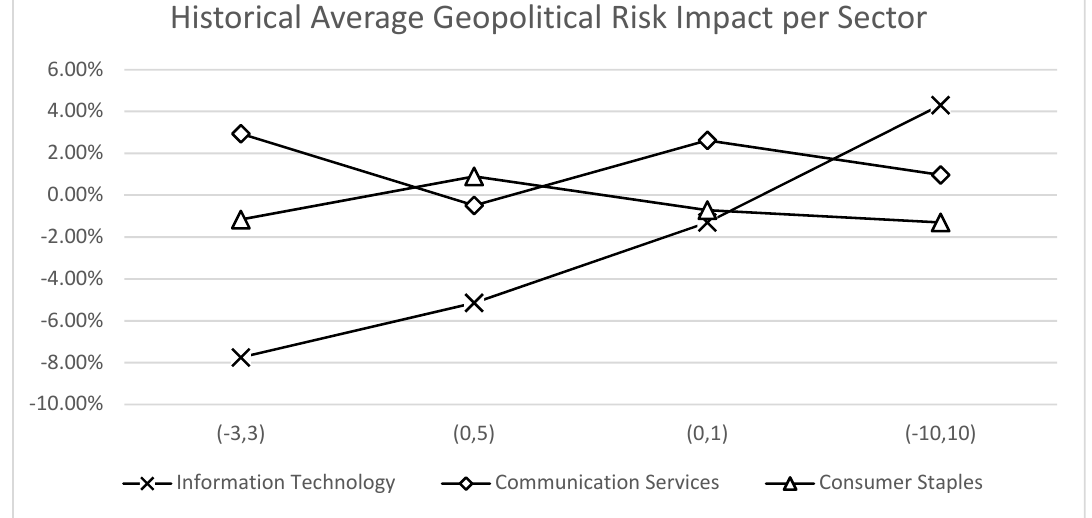
Figure A4. Summary of events with statistically significant CAARs for the Information Technology, Communication Ser- vices, and Consumer Staples sectors. References (Agmon 1973) Agmon, Tamir. 1973. Country Risk: The Significance of the Country Factor for Share-Price Movements in the United Kingdom, Germany, and Japan. The Journal of Business 46: 24–32. Available online: http://www.jstor.com/stable/2351277 (accessed on 20 March 2020). (Amiti et al. 2019) Amiti, Mary, Stephen J. Redding, and David E. Weinstein. 2019. The Impact of the 2018 Tariffs on Prices and Welfare. Journal of Economic Perspectives 33: 187–210. doi: 10.1257/jep.33.4.187. (Antonakakis et al. 2017) Antonakakis, Nikolaos, Rangan Gupta, Christos Kollias, and Stephanos Papadamou. 2017. Geopolitical risks and the oil-stock nexus over 1899–2016. Finance Research Letters 23: 165–73. https://doi.org/10.1016/j.frl.2017.07.017. (Atems et al. 2020) Atems, Bebonchu, Michael Maresca, Baomei Ma, and Emily McGraw. 2020. The impact of El Nio-Southern Oscillation